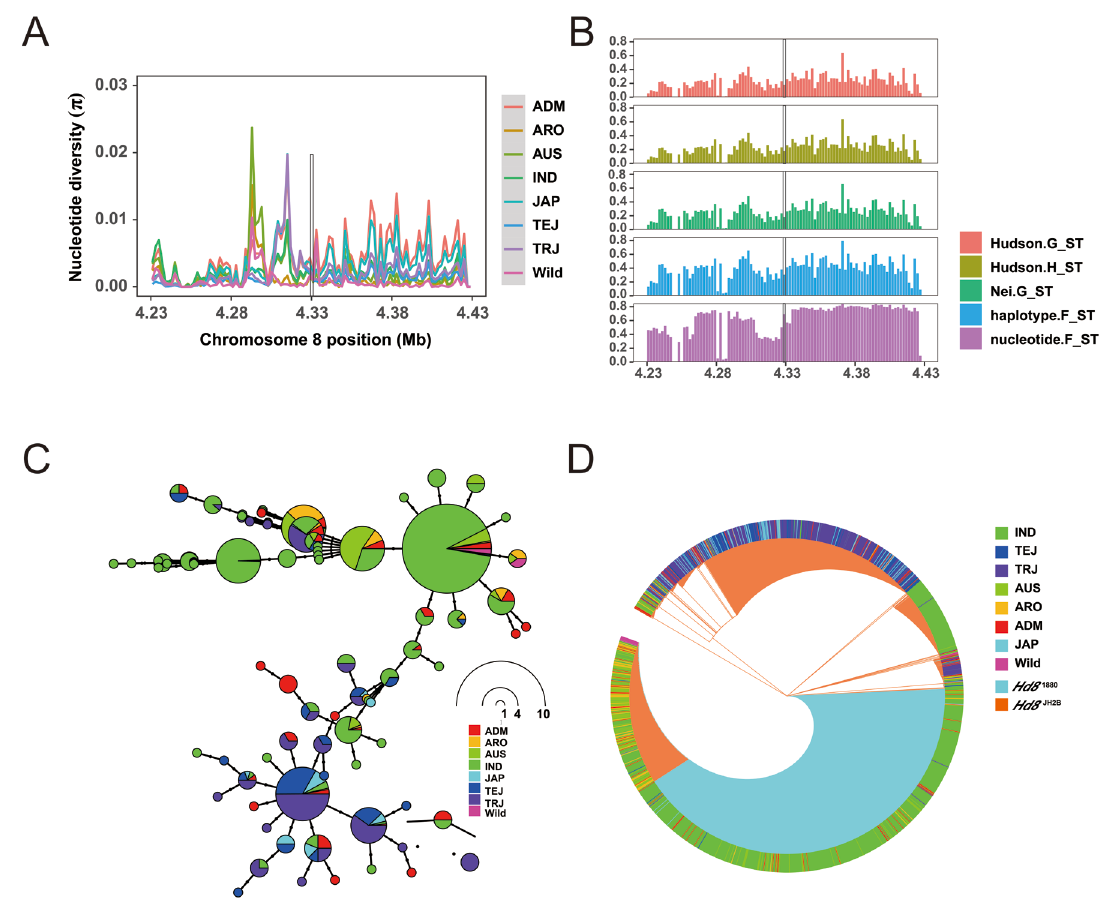
Figure 8. Phylogenetic relationship and genetic variation analysis of OsHd8 . ( A ) Nucleotide diversity and selection analysis of OsHd8 and its flanking region (~200 kb). From Rice SNPS-Seek Database (https://snp-seek.irri.org/_snp.zul, accessed on 20 April 2022) and OryzaGenome (http://viewer.shigen.info/oryzagenome/, accessed on 22 April 2022), Genomic sequences of 3024 cultivated germplasm and 32 wild germplasm were obtained. ADM means admixed , ARO means aromatic , AUS means aus , IND means indica , JAP means unclassified japonica , TEJ means temperate japonica , TRJ means tropical japonica ; ( B ) The parameters of genetic difference between indica and japonica ecotypes for OsHd8 and its flanking genomic regions; ( C ) Haplotype network of OsHd8 . The size of the circle is proportional to the number of samples given to the order. The black dots on the lines indicate the mutation steps between haplotypes; ( D ) Phylogenetic relationship of OsHd8 generated between 3024 cultivated rice and 32 wild rice accessions. The orange and blue rectangles represent the types of Hd8 1880 and Hd8 JH2B , respectively.